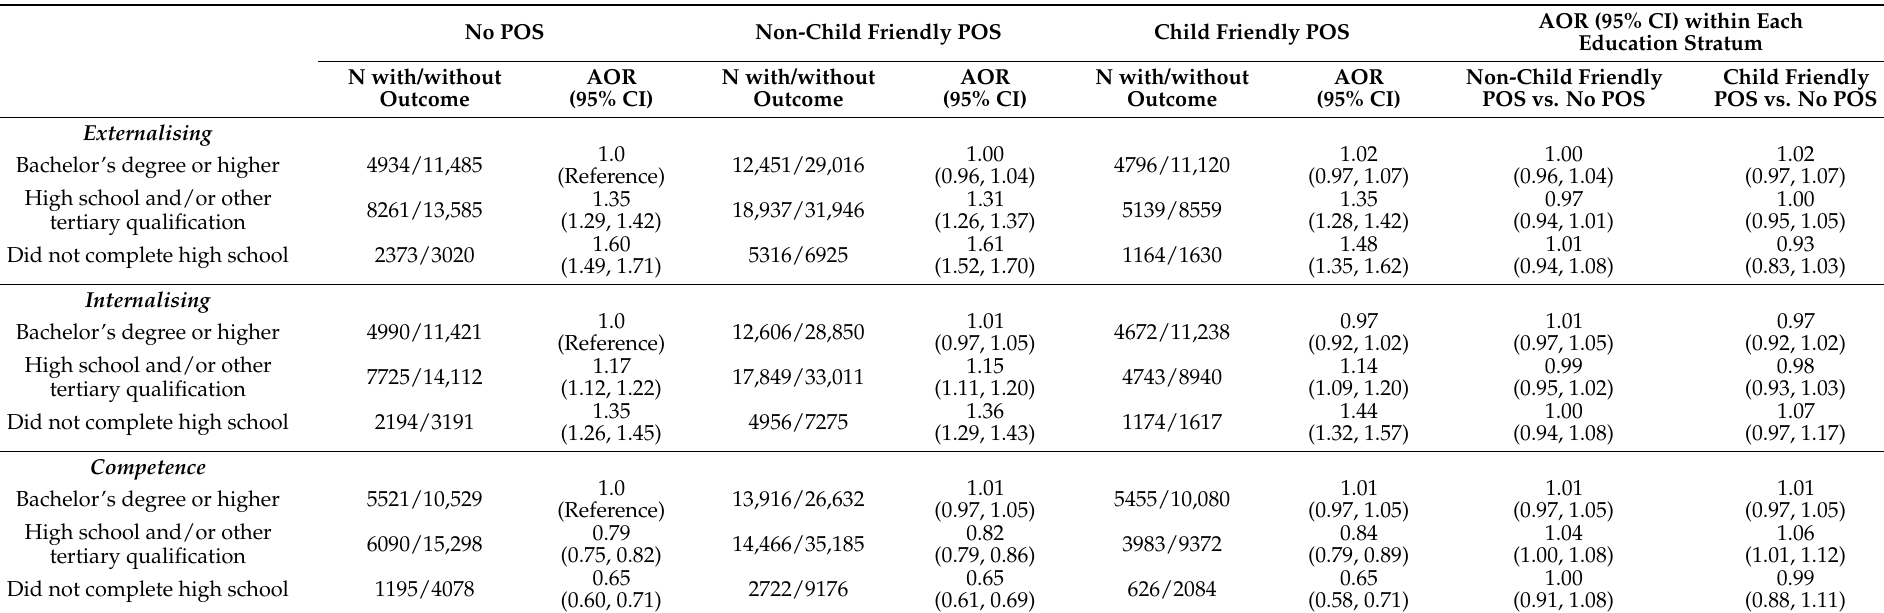
Table 4. Results from investigation of effect modification for measures of public open space within 400 m. Based on template developed by Knol and VanderWeele [67]. AOR (95% CI) within Each No POS Non-Child Friendly POS Child Friendly POS Education Stratum AOR AOR AOR N with/without N with/without N with/without Non-Child Friendly Child Friendly (95% CI) (95% CI) (95% CI) Outcome Outcome Outcome POS vs. No POS POS vs. No